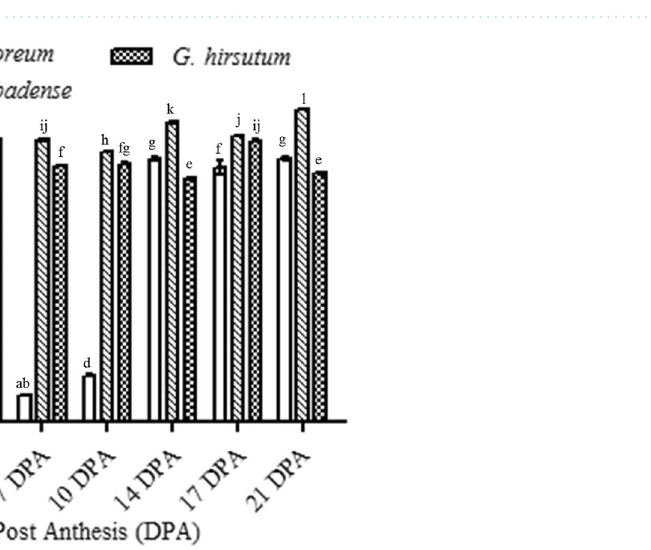
Figure 7. 1-Aminocyclopropane-1-carboxylic acid (ACC) chromatogram obtained through high performance liquid chromatography (HPLC) in the developing fibers of G. barbadense.